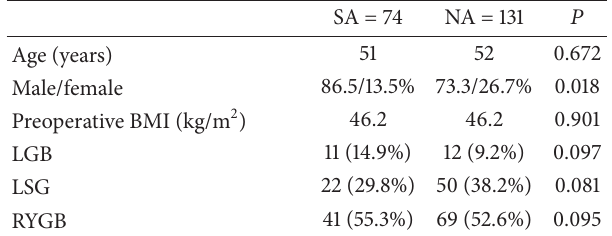
Table 1: Demographic data comparing cohorts.